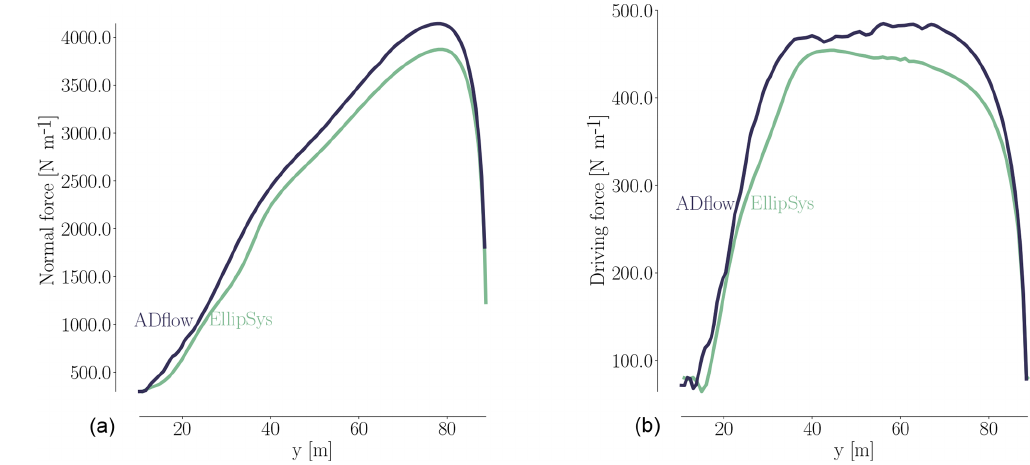
Figure A2. Spanwise distribution of the normal force (a) and driving force (b) for the 8ms − 1 case listed in Table A1.